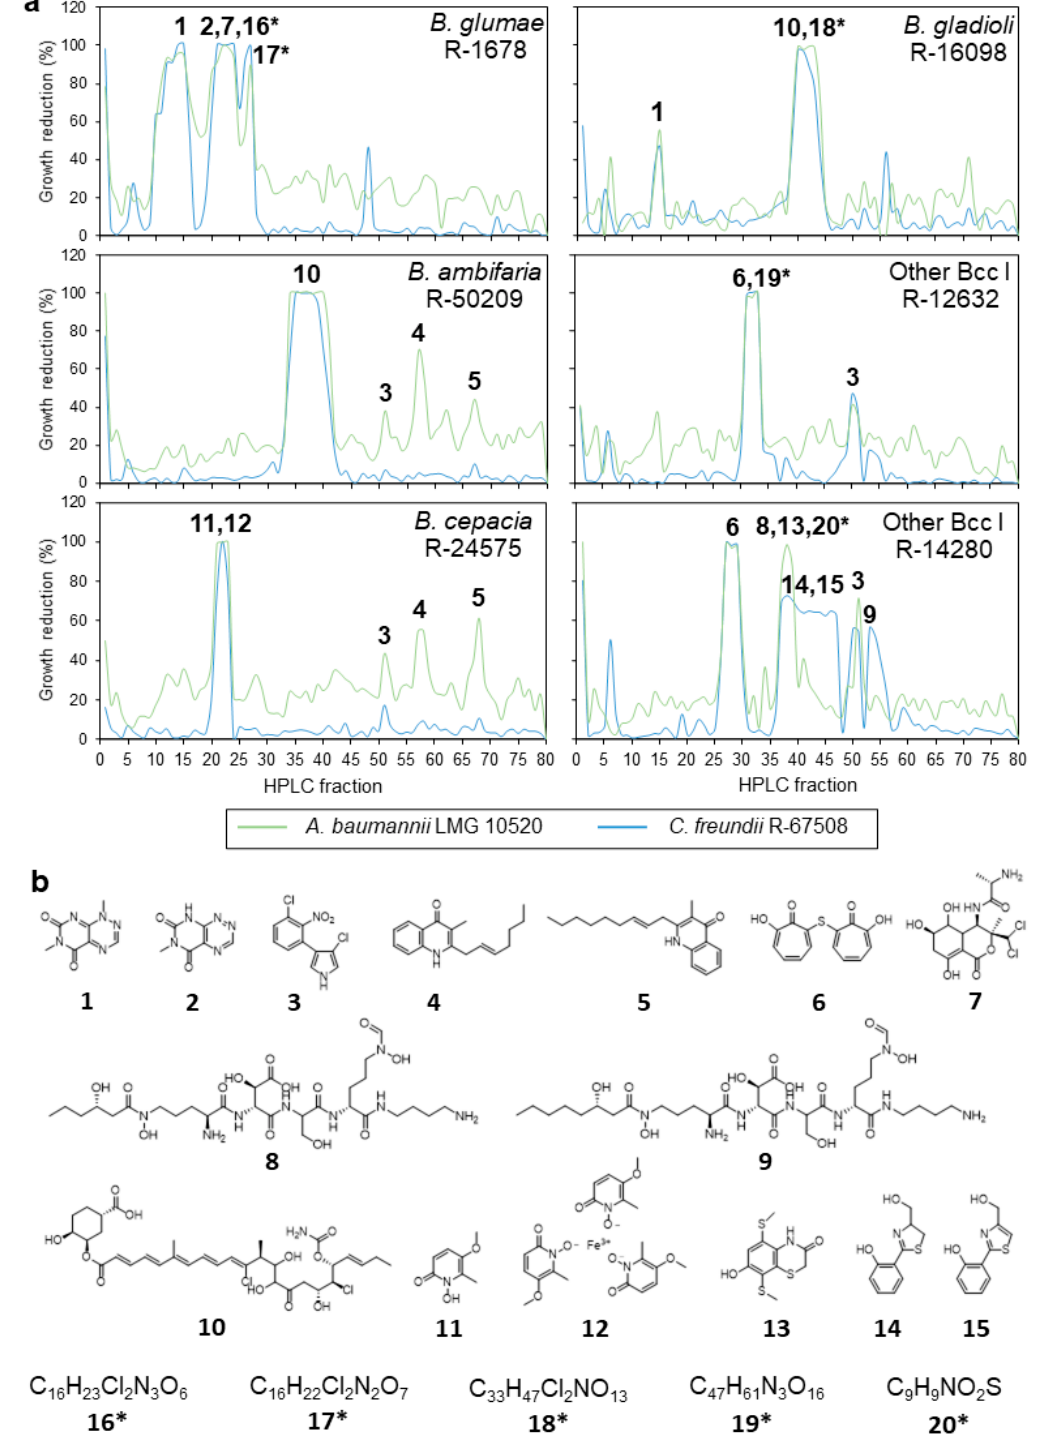
Figure 1. Antimicrobial activity and specialized metabolites detected in semipreparative fractions of six Burkholderia isolates. ( a ) Growth reduction observed per HPLC fraction. Numbers indicate specialized metabolites detected in active fractions and correspond with the chemical structures in panel b. ( b ) Chemical structures of compounds detected in active fractions. 1, reumycin; 2, toxoflavin; 3, pyrrolnitrin; 4, C 17 H 21 NO; 5, antibiotic SF 2420B; 6, ditropolonyl sulfide; 7, bactobolin A; 8, ornibactin C6; 9, ornibactin C8; 10, enacyloxin IIb; 11, cepabactin; 12, antibiotic BN-227-F; 13, C 10 H 11 NO 2 S 3 ; 14, aerugine; 15, aeruginol; 16, C 16 H 23 Cl 2 N 3 O 6 ; 17, C 16 H 22 Cl 2 N 2 O 7 ; 18, C 33 H 47 Cl 2 NO 13 ; 19, C 47 H 61 N 3 O 16 ; 20, C 9 H 9 NO 2 S. Asterisks indicate putative novel